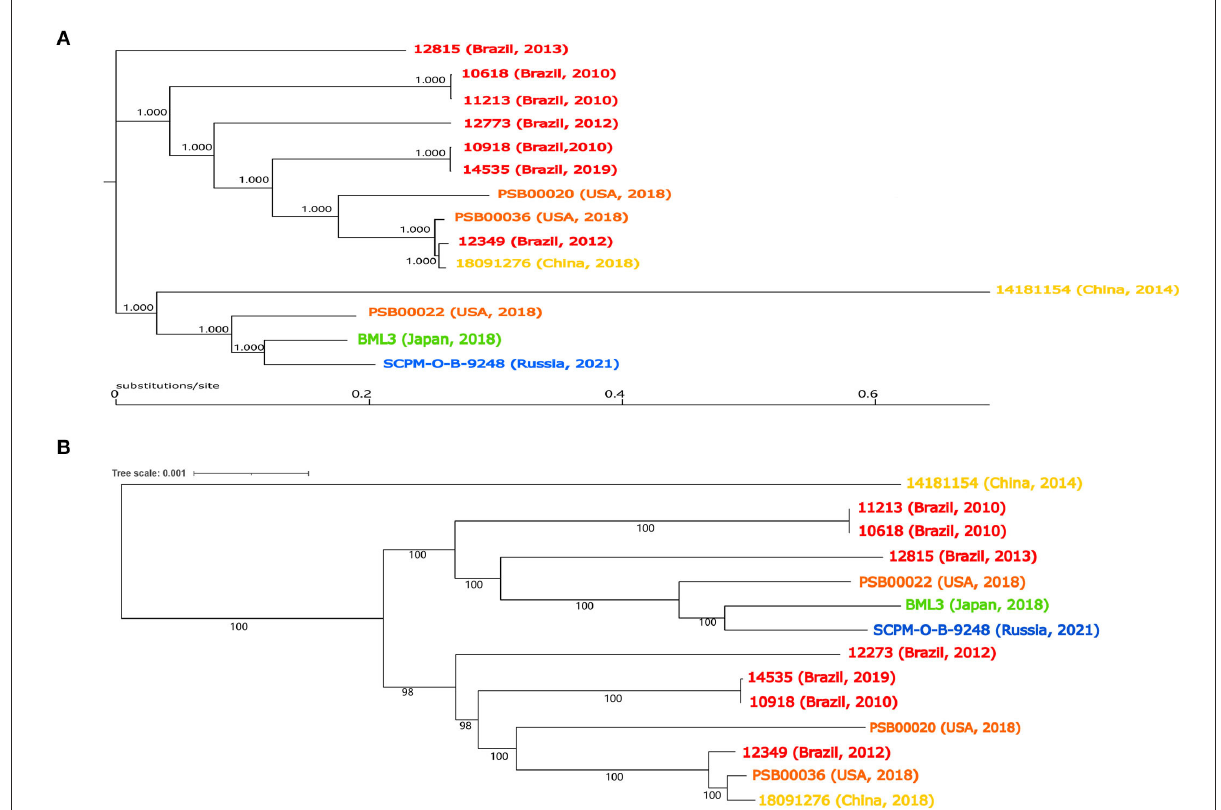
FIGURE1 Pseudomonas juntendi genome phylogenetic tree. The top half is the phylogenetic tree constructed from SNPs of genomes (A) . The bottom half of the figure is the phylogenetic tree constructed from core genomes (B) . The Brazilian isolates are labeled in red, Chinese isolates are labeled in khaki, American isolates are labeled orange, Japanese isolates are labeled green, and Russian isolates are labeled